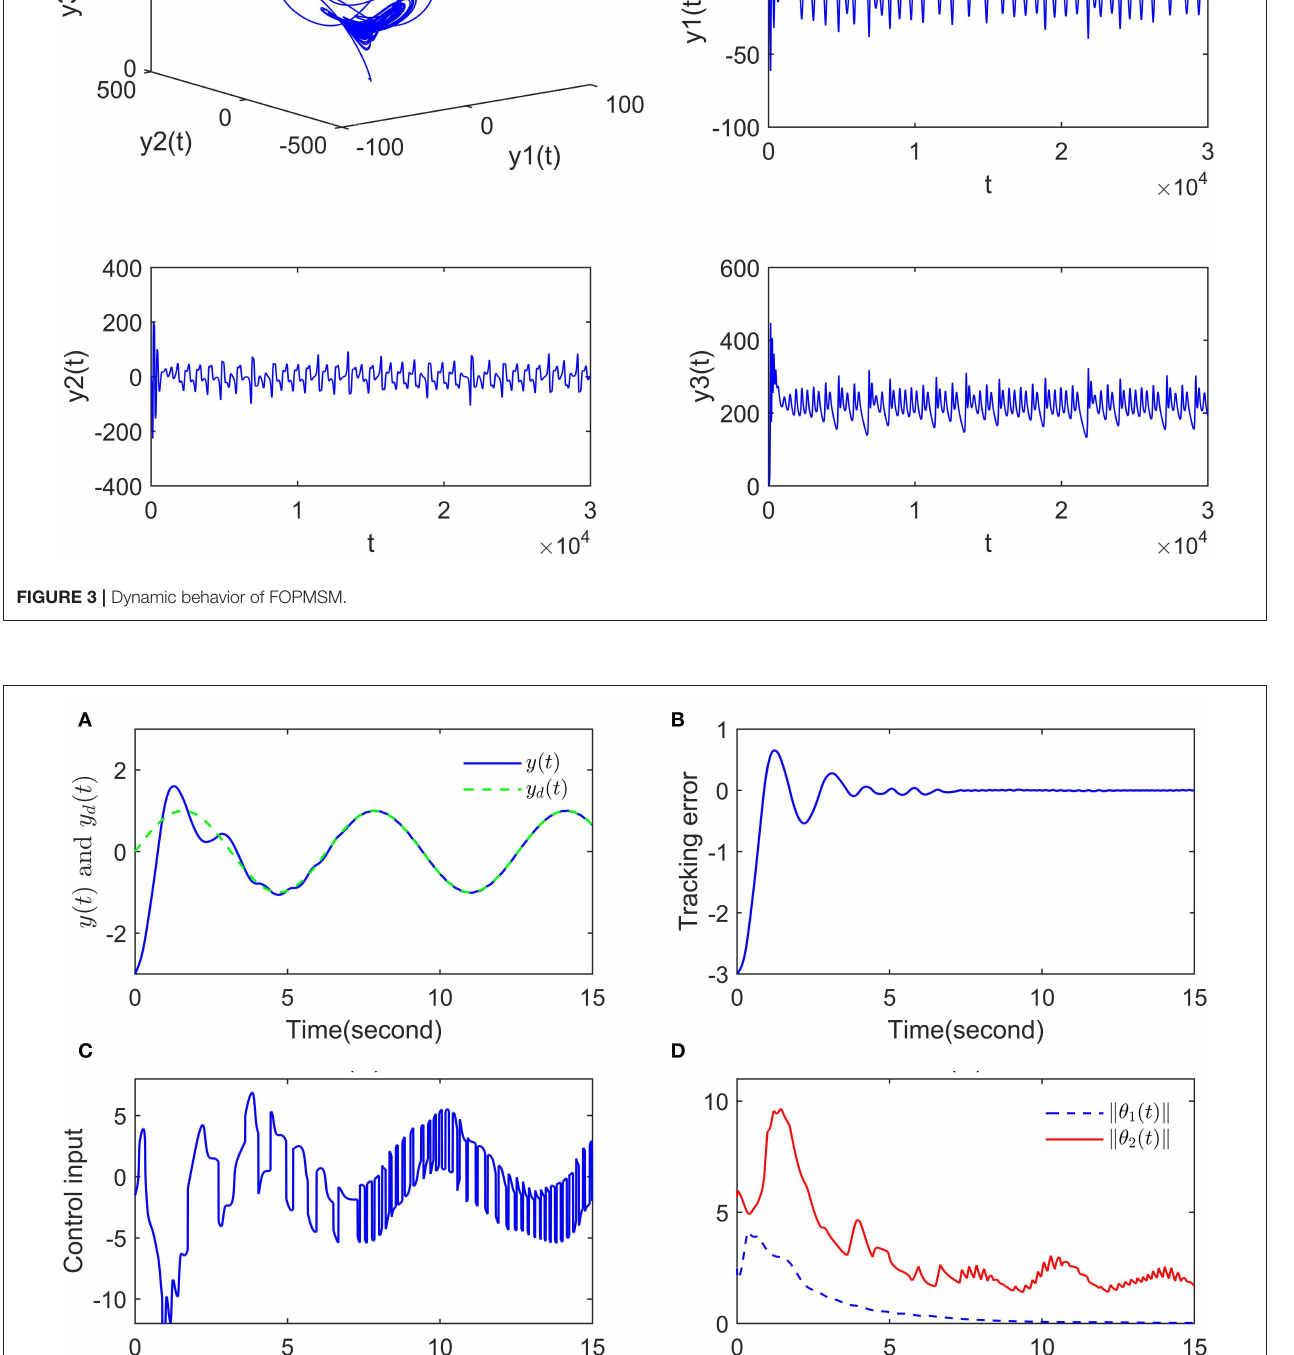
Frontiers in Physics |